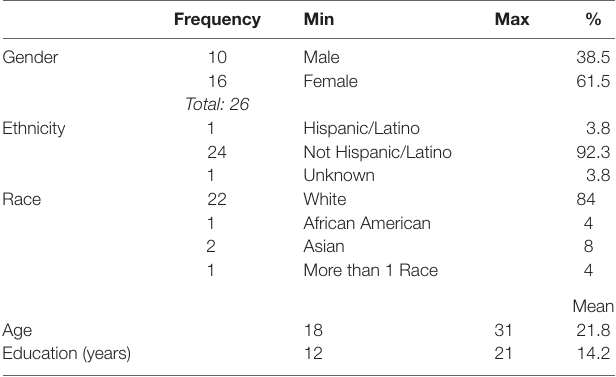
TABLE 1 | Sociodemographic characteristics of